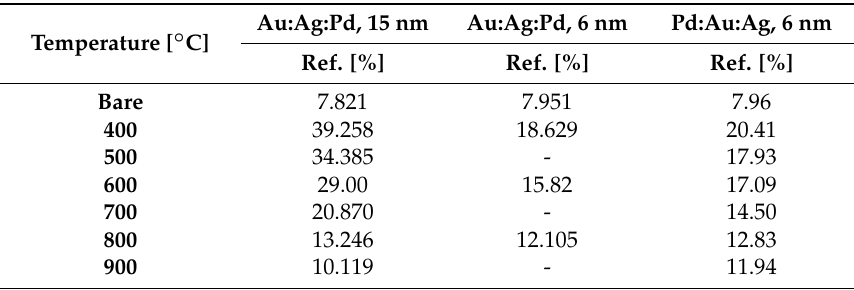
Table A2. Summary of average reflectance (ref.) of the samples at various temperature, composition, and film thickness.